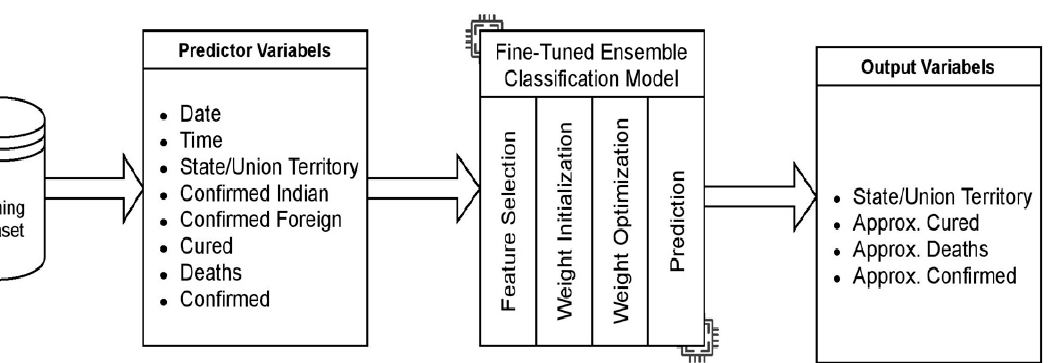
Table 3. Performances of various classifiers in COVID-19 prediction.